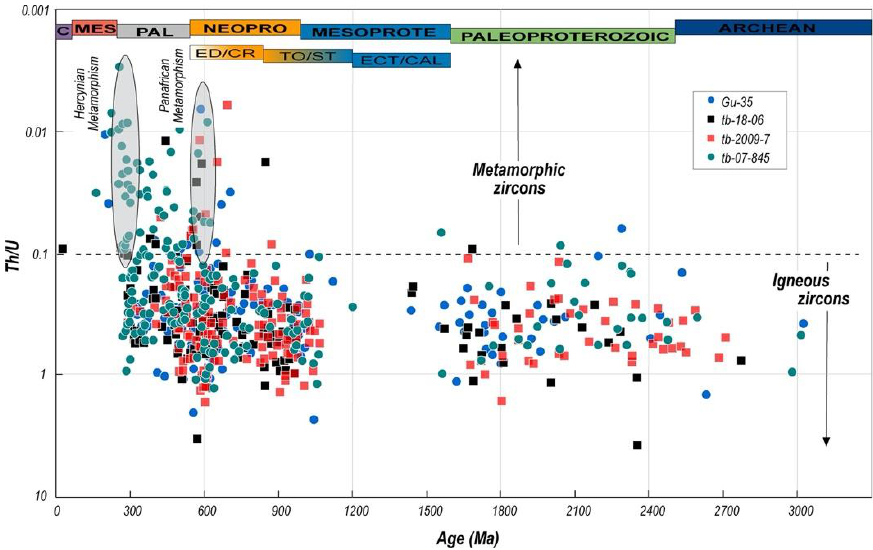
Figure 7. Th/U vs 206 Pb/ 238 U Age (Ma) of analysed zircons of Guadaiza nappe´s samples.